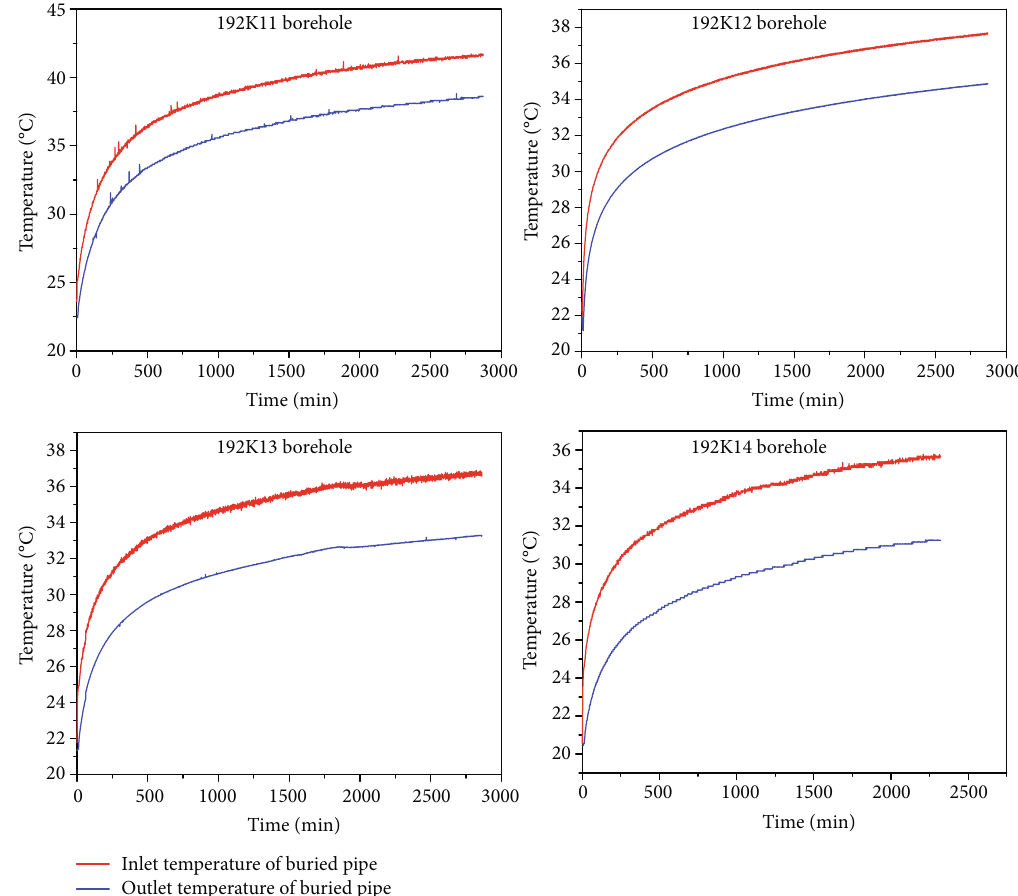
Figure 10: Results of high-power constant heat fl ux test in four geothermal